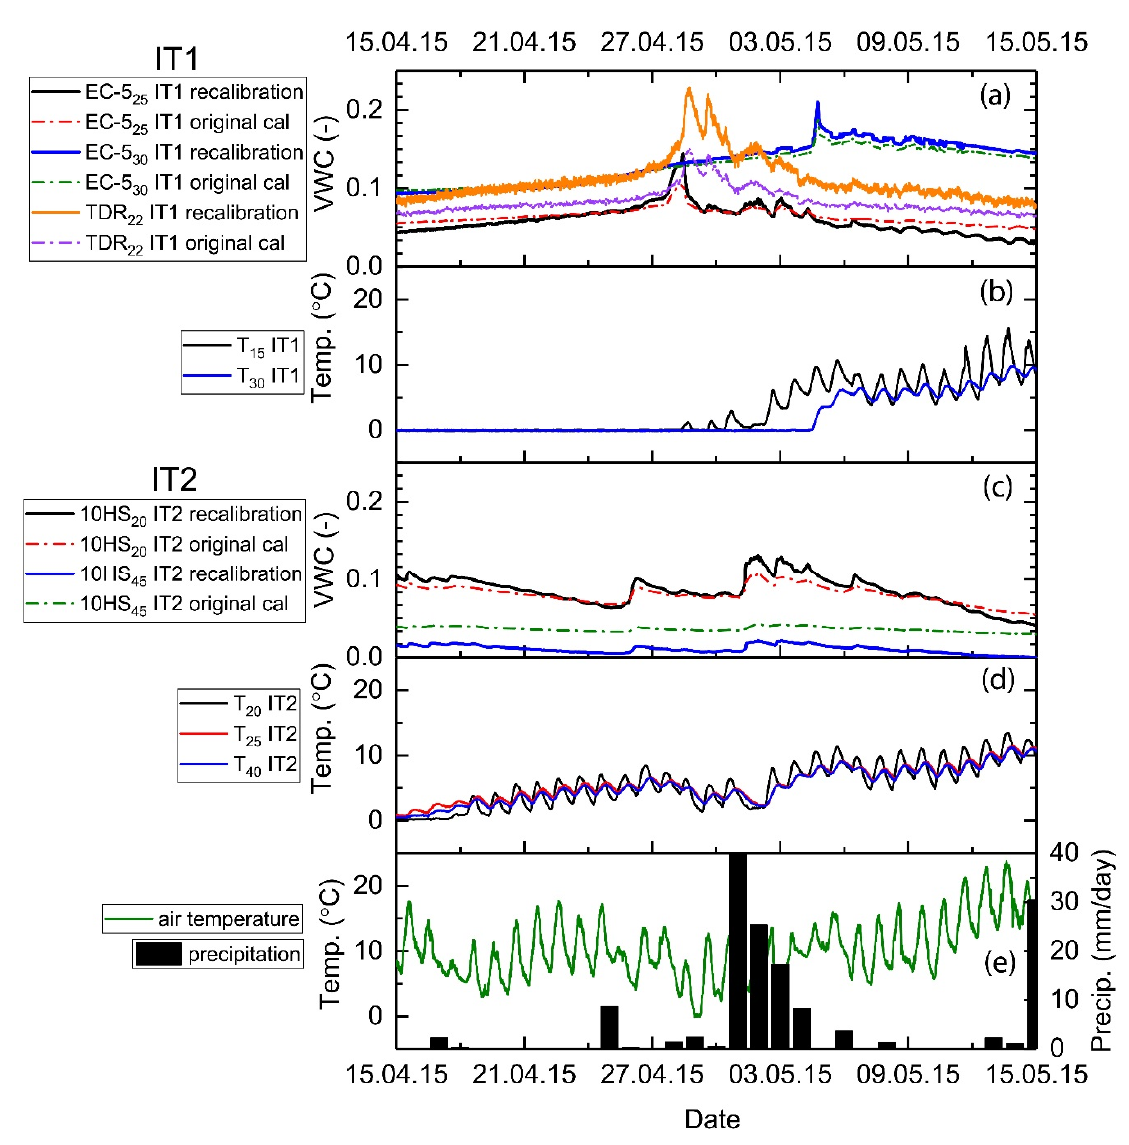
Figure 16. Data Period 3: 15 April 2015–15 May 2015. Site-specific calibration: comparison between data based on original calibration and the recalibration for the spring period.